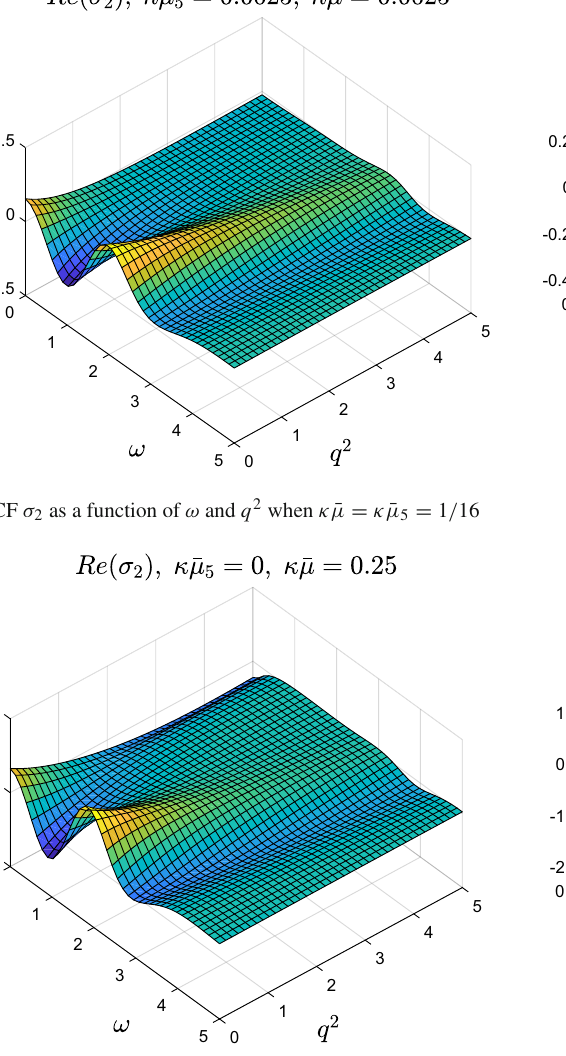
Fig. 16 TCF σ 2 as a function of ω and q 2 when κ ¯ μ = 1 / 4, κ ¯ μ 5 = 0